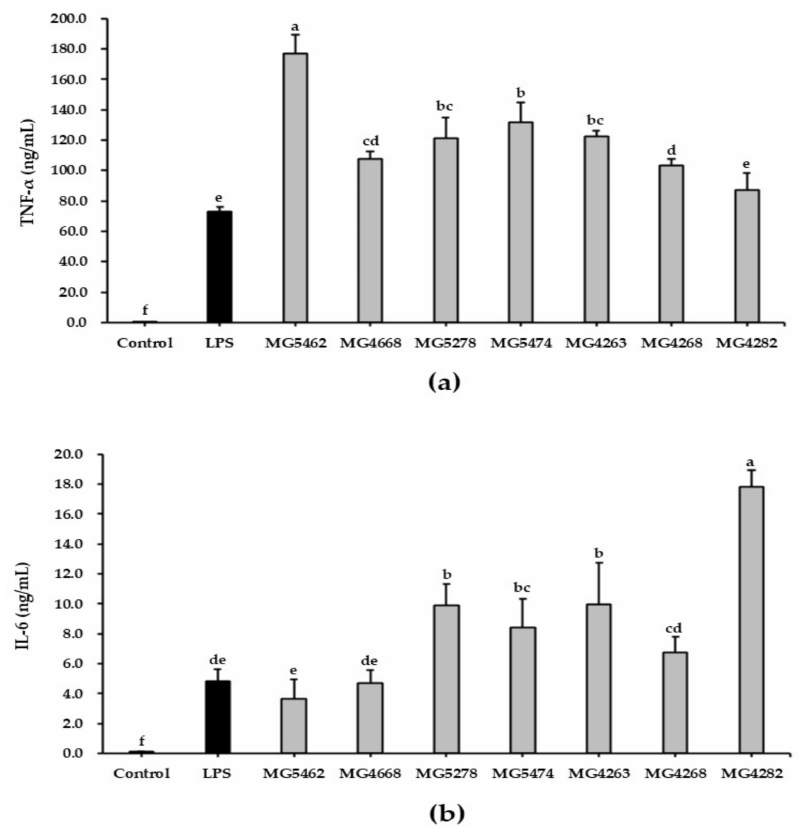
Figure 3. Effect of CFS from LAB strains on cytokine production in RAW264.7 cells. Cells were treated with LPS (10 ng/mL) or CFS (5 mg/mL) for 24 h. The amounts of TNF- α ( a ) and IL-6 ( b ) secreted by cells were measured using an ELISA kit. Data are presented as the mean ± SD of three independent experiments ( n = 3). Different letters indicate significant differences between means at p < 0.05 based on Duncan’s multiple range